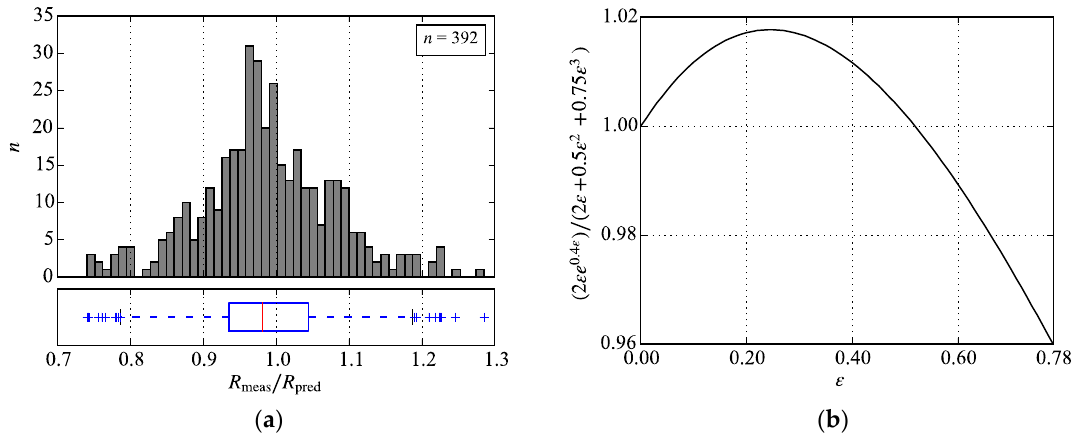
Figure 13. ( a ) Histogram and boxplot with whiskers at 2.5th and 97.5th percentile of measured over predicted (Equation (10)) runup height R meas / R pred of the overall dataset; ( b ) 2 εe 0.4 ε over Equation (6) versus relative wave amplitude ε .